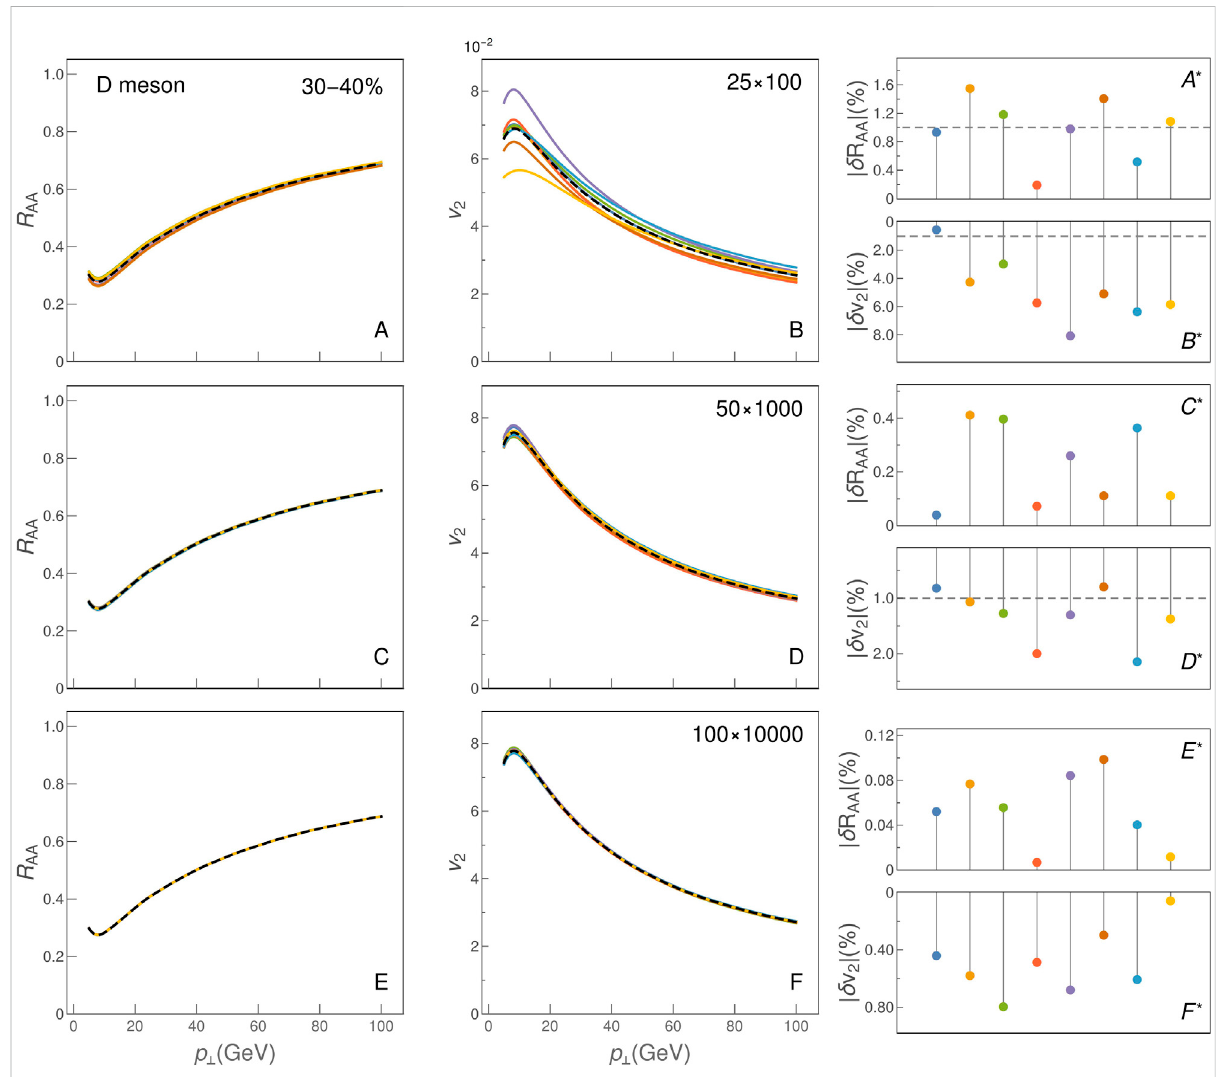
trajectories. The dashed horizontal line in rightmost panels indicates the threshold of 1% deviation. The top row depicts results obtained from sampling 25 trajectories at different angles originating from each of 100 randomly selected jet-production points; the middle row — 50 angles